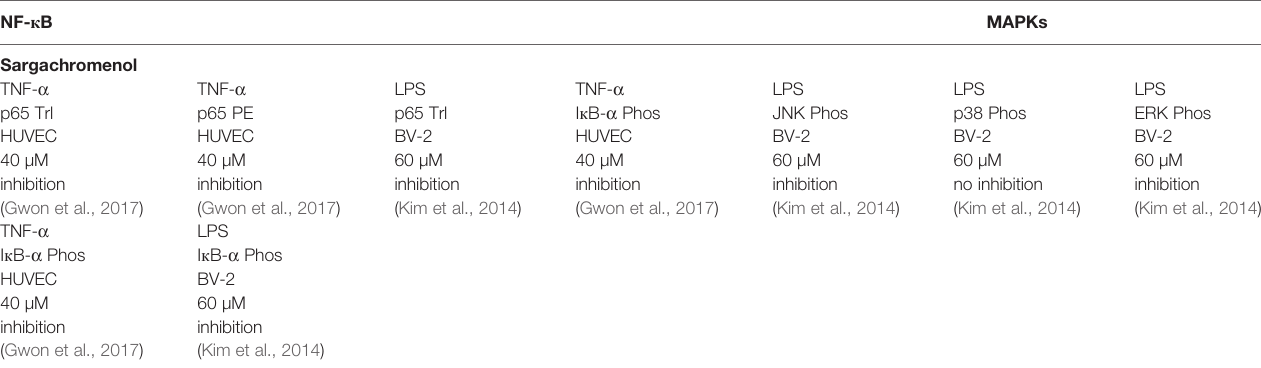
TABLE 5 | Overview on the interference of chromenols with molecular targets and key enzymes connecting in fl ammation and carcinogenesis. NF- к B